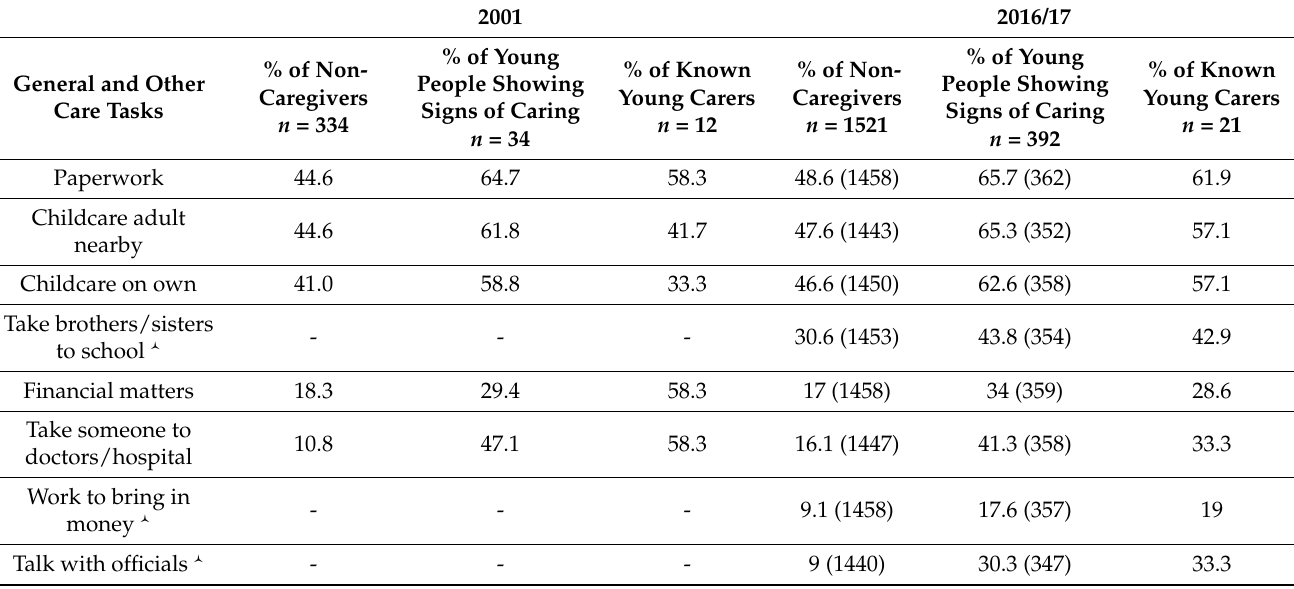
Table 3. Nature of general and other care tasks undertaken by non-caregivers, young people showing signs of caring and known young carers in 2001 and 2016/17.